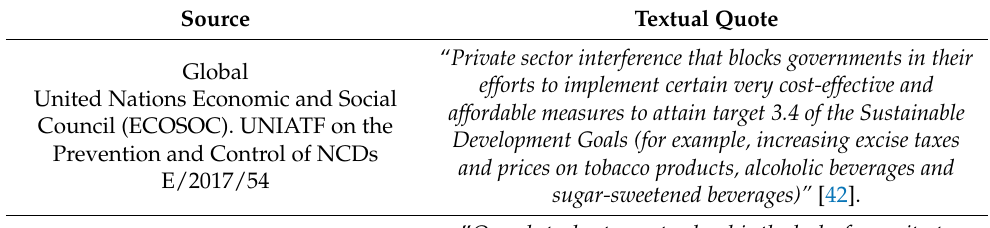
Table 2. Evidence of private sector